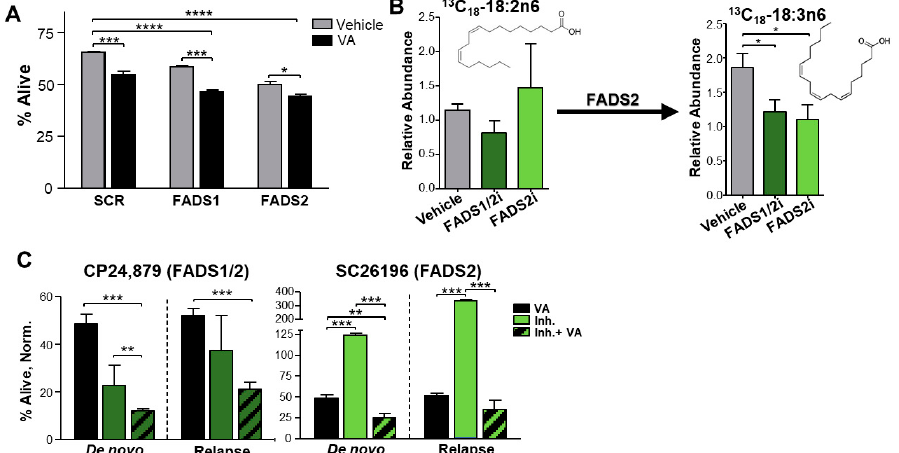
Figure 5. FADS1 and 2 can be genetically and pharmacologically targeted. ( A ) Percentage of MOLM- 13 AML cells alive after treatment with scramble siRNA + vehicle; scramble siRNA + 500 nM veneto- clax + 2.5 µ M azacitidine; FADS1 or FADS2 siRNA + vehicle; and FADS 1 or FADS2 siRNA + 500 nM venetoclax + 2.5 µ M azacitidine. ( B ) Relative abundance of 13C18- heavy stable isotope labeled linoleic acid and 13C18- heavy stable isotope labeled gamma-linoleic acid, substrate and product of FADS2, upon treatment with 0.5 µ M CP24,879 (FADS1 and FADS2 inhibitor) and 5 µ M SC26196 (FADS2 inhibitor) for 8h in primary relapsed patient LSCs (relapse patient 3). ( C ) Percentage of primary de novo and relapsed patient LSCs alive, normalized to vehicle treatment with 500nM ve- netoclax + 2.5 μ M azacitidine; 500nM venetoclax + 2.5 μ M azacitidine with 0.5 μ M FADS1 and 2 in- hibitor (CP24,879); and 500nM venetoclax + 2.5 μ M azacitidine with 5 μ M FADS2 inhibitor (SC26196) for 24 h (paired patient 3, de novo and relapsed). * p ≤ 0.05, ** p ≤ 0.01, *** p ≤ 0.001, **** p ≤ 0.0001.